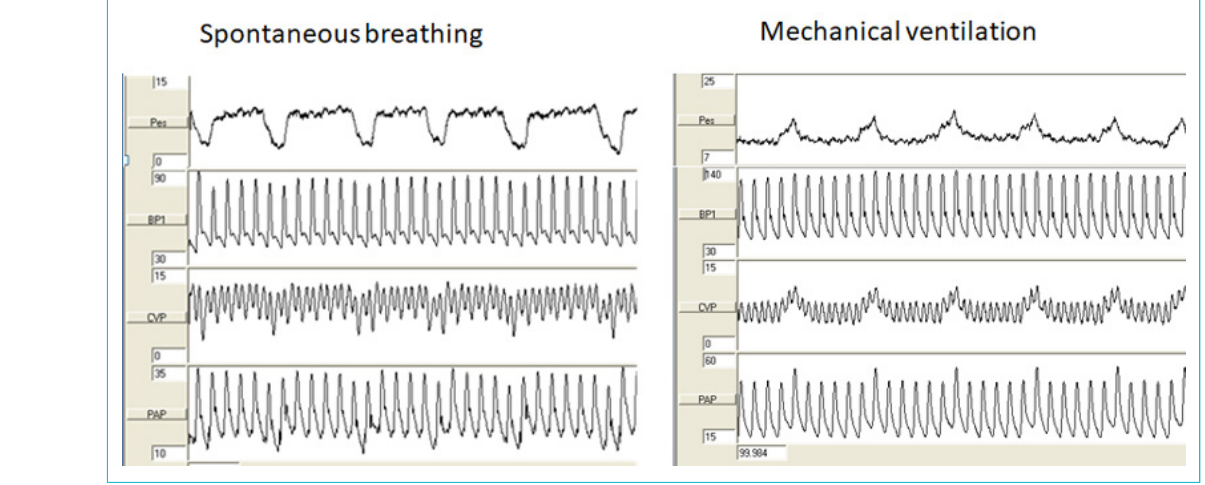
Figure 4: Respiratory pressure variations. With spontaneous breathing, increasingly negative pleural pressure during inspiration (surrogat- ed by oesophageal pressure, left panel) is transmitted to central venous, pulmonary artery and arterial blood pressure (inspiratory drops). With mechanical ventilation, this pattern is reversed. Original pressure tracings from reference